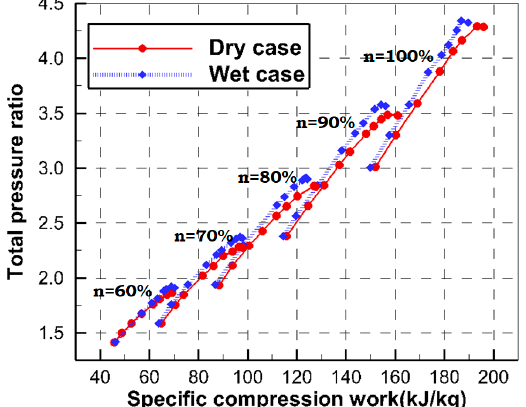
Figure 10. Correlation of pressure ratio with specific compression work for dry and wet cases.